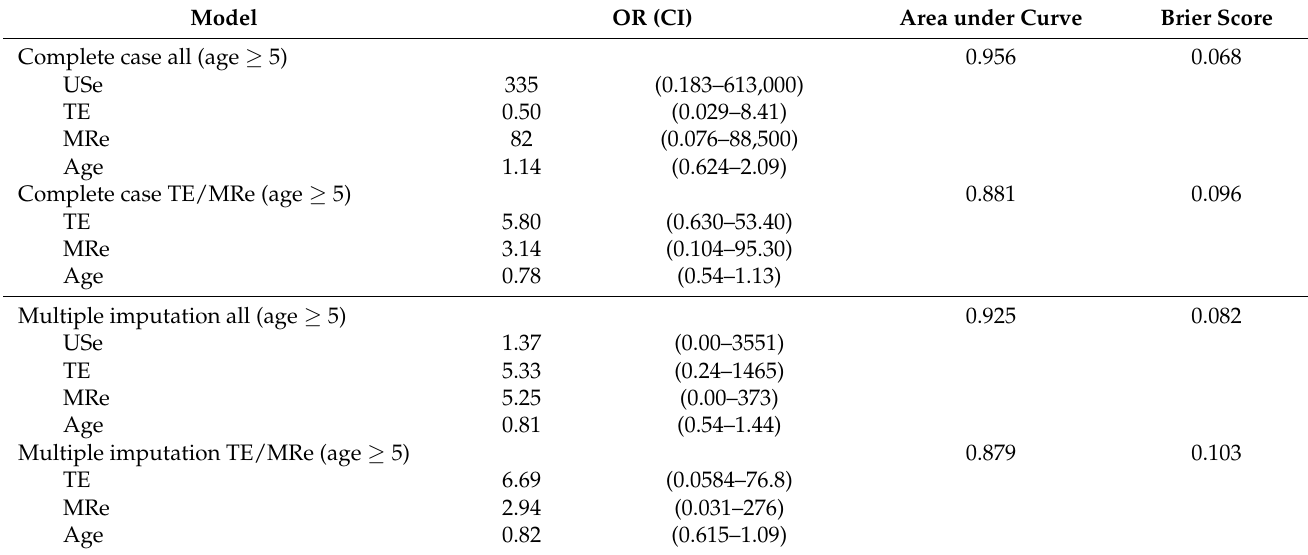
Table 3. Results from multivariate logistic regression models with advanced fibrosis (F3-4) as outcome and combination of liver stiffness measures age and Alanine aminotransferase levels ≤ 470 as